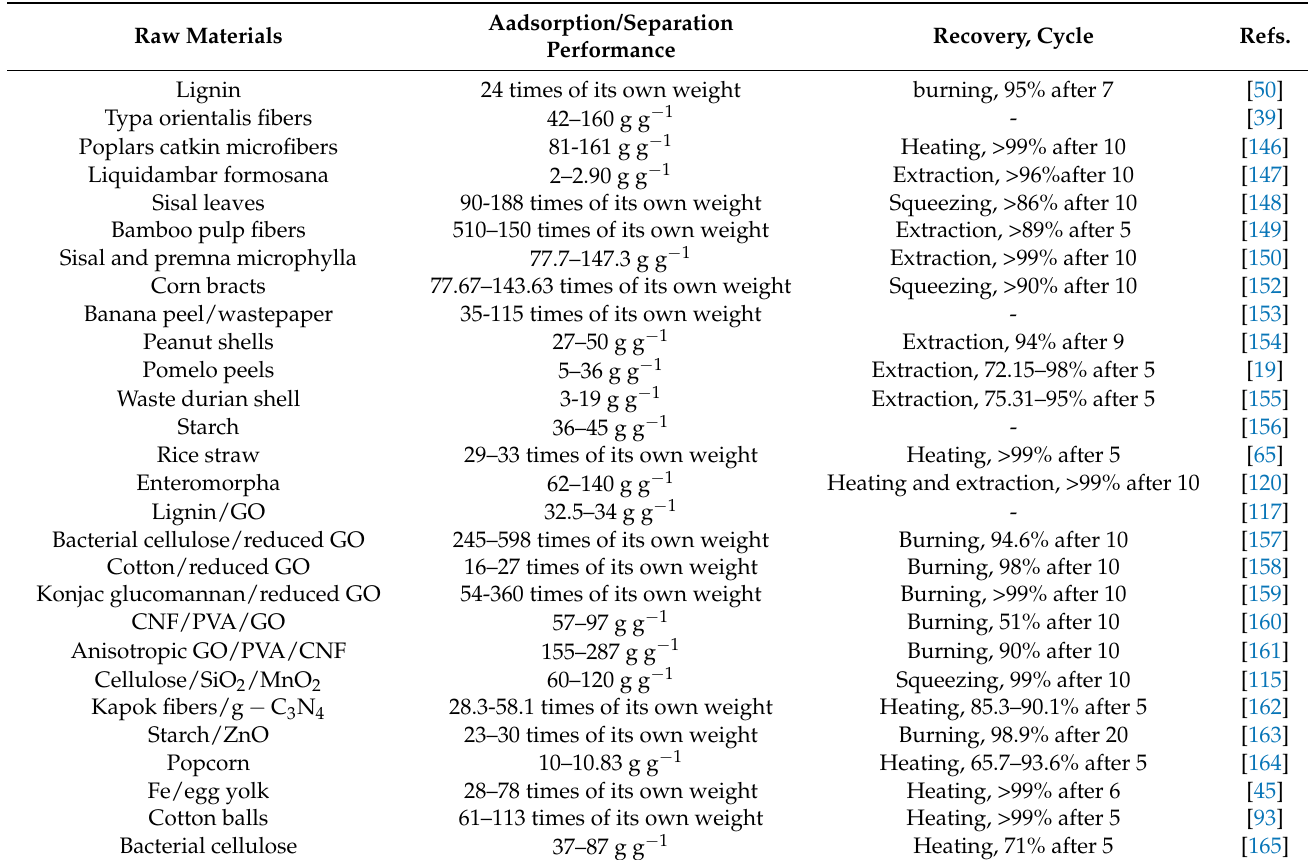
Table 6. Bio-carbon based sorbents for spill oil